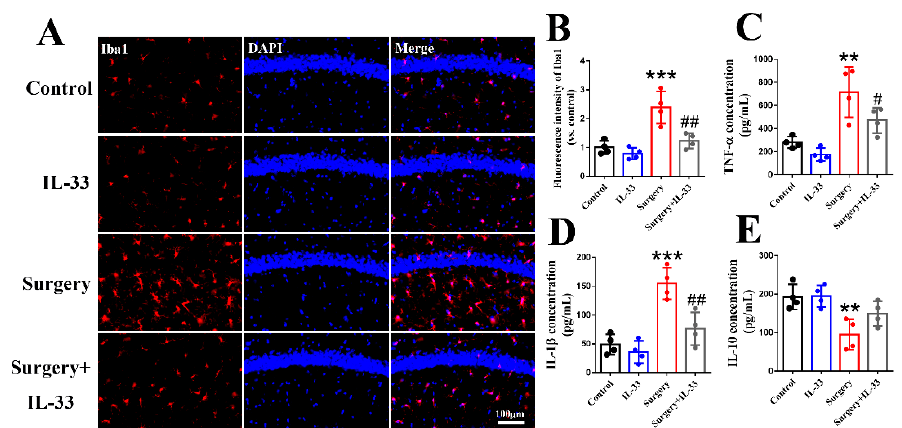
Figure 3. IL-33 inhibits surgery/anesthesia-induced hippocampal inflammation in aged mice. Acti- vation of microglia in the hippocampus was indicated by Iba1 ( A , B ). The levels of TNF- α ( C ), IL-1 β ( D ) and IL-10 ( E ) were detected by ELISA 3 days after surgery. Data are expressed as the mean ± SD (one-way ANOVA followed by Bonferroni’s post hoc test, n = 4 per group). ** p < 0.01 and *** p < 0.001 versus the control group; # p < 0.05 and ## p < 0.01 versus the surgery group.